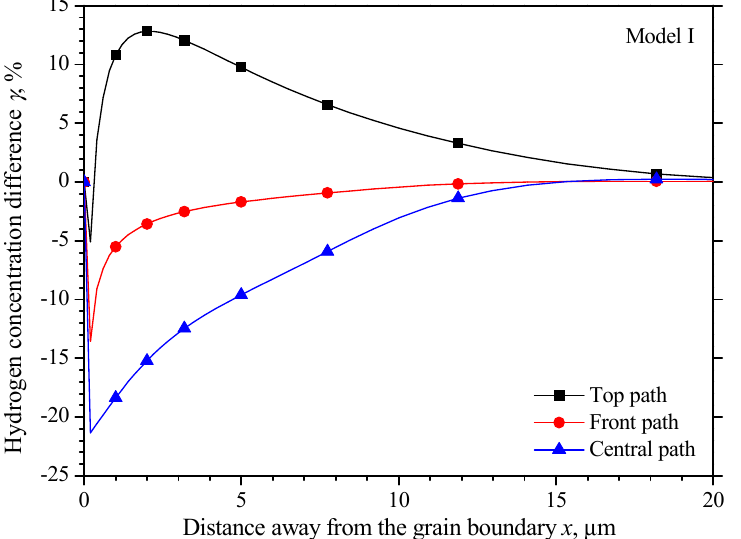
Figure 7. Hydrogen concentration difference equidistant from the grain boundary of model I.